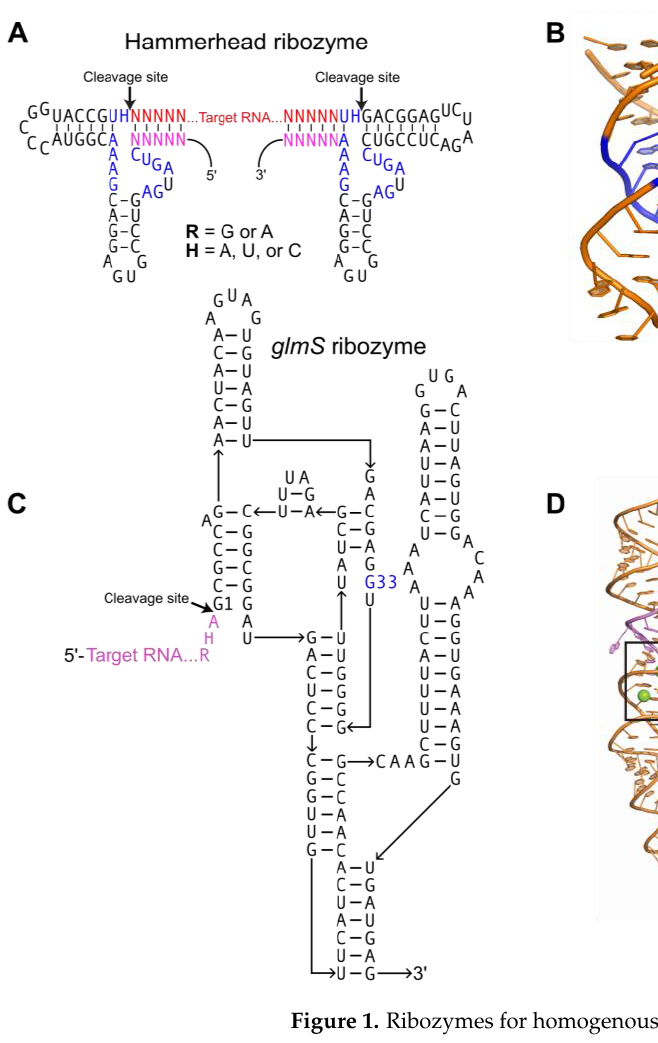
Figure 1. Ribozymes for homogenous RNA end production: ( A ) Secondary structure of two hammerhead ribozymes connected by an RNA crystallization target. Conserved nucleotides necessary for catalysis (blue); short complements (magenta) to the 5′ and 3′ ends of the target RNA (red) must be engineered into the ribozyme sequence. Canonical base pairs in helical stems are denoted by dashes. R = G or A; H = A, U, C; N = A, U, C, G. ( B ) Tertiary structure of the minimal hammerhead ribozyme (PDB:300D). Color scheme matches Figure 1A. Inset shows the ribozyme active site turned upward, with catalytic residues, participating substrate residues, and metal ions labeled. ( C ) Secondary structure for a glmS ribozyme consisting of the target RNA (purple) and ribozyme strand (black). The G33 (blue) residue interacts with Glc6P and is required for catalysis. ( D ) Tertiary structure of the Bacillus anthracis glmS ribozyme (PDB:3L3C) bound to Glc6P (shown as sticks) before cleavage. Color scheme matches Figure 1C. Inset shows the ribozyme active site, with catalytic residues and participating substrate residues (shown as sticks) labeled. Hydrogen bonds between catalytic residues, substrate, and Glc6P indicated by black dashes; cleavage site indicated by arrow. Conserved G33 residue colored blue; bound Mg 2+ shown as green spheres.